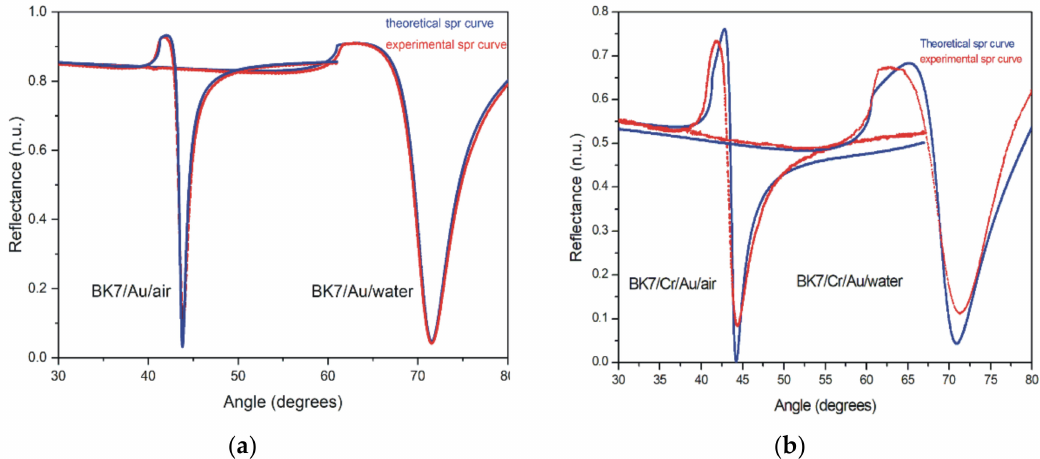
Figure 1. Theoretical (blue line) and experimental (red line) normalized SPR curve, employed to